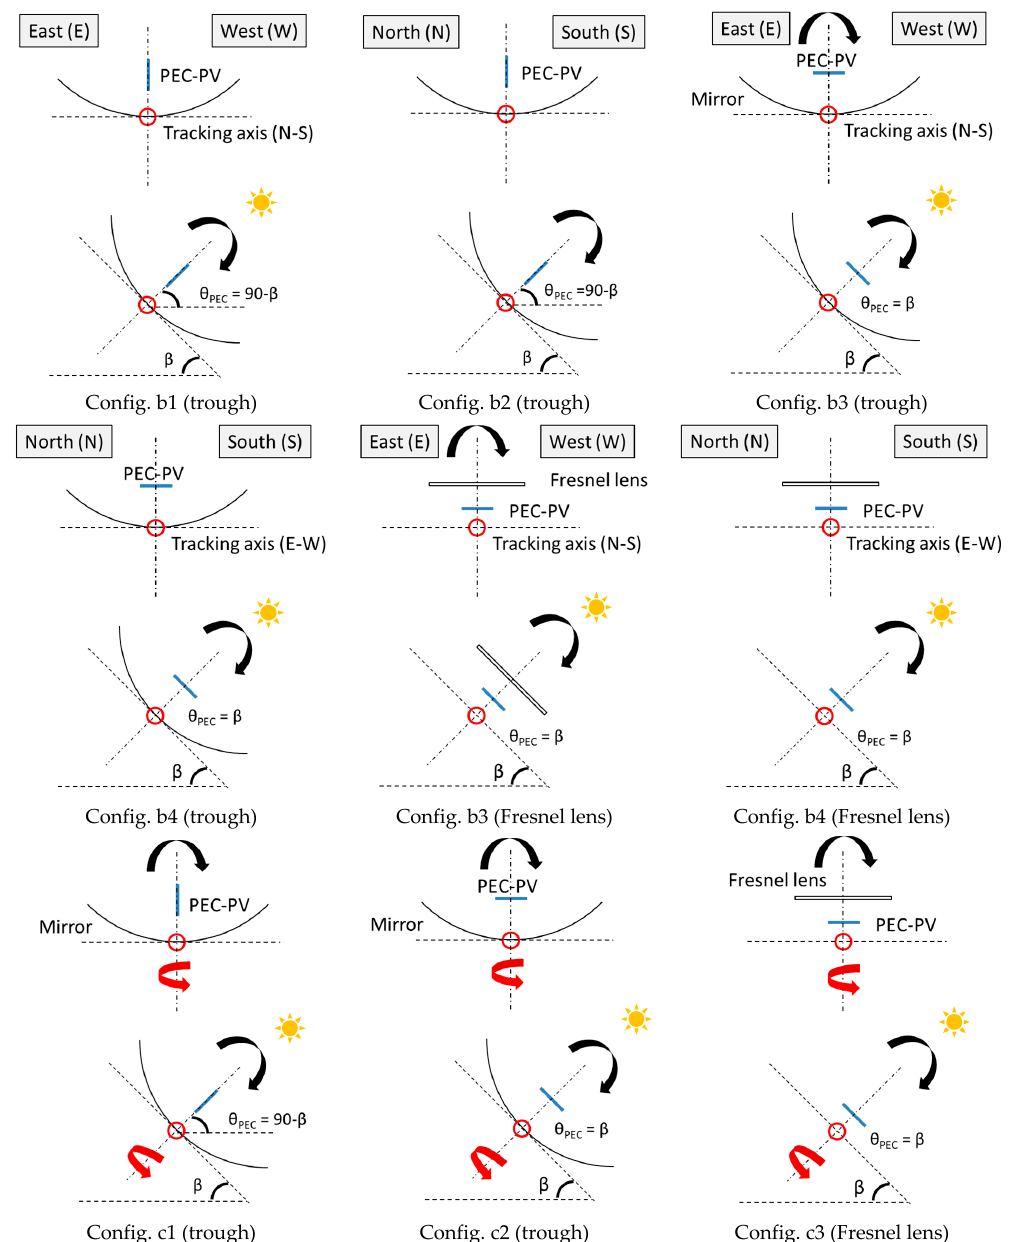
Figure A4. Illustration of geometrical configurations listed in Table 5.